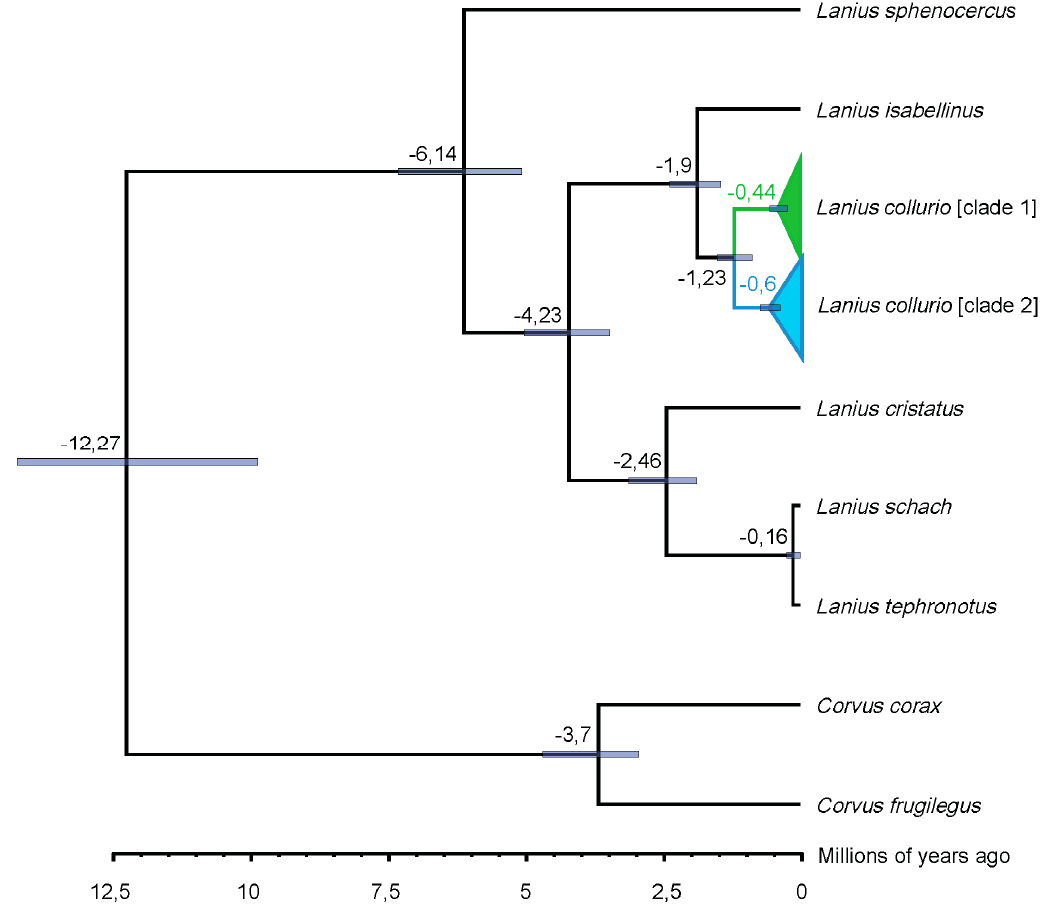
Figure 4. Maximum clade credibility tree (Beast) based on Cytb and CO1 genes, for L. sphenocercus , L. isabellinus , L. collurio , L. cristatus , L. schach , L. tephronotus and, as outgroup, Corvus corax and Corvus frugilegus . Values expressed on branch ramifications indicate node age; 95% highest posterior densities are displayed as node bars. Table 3. Estimates of evolutionary divergence (base substitutions per site) over sequence pairs